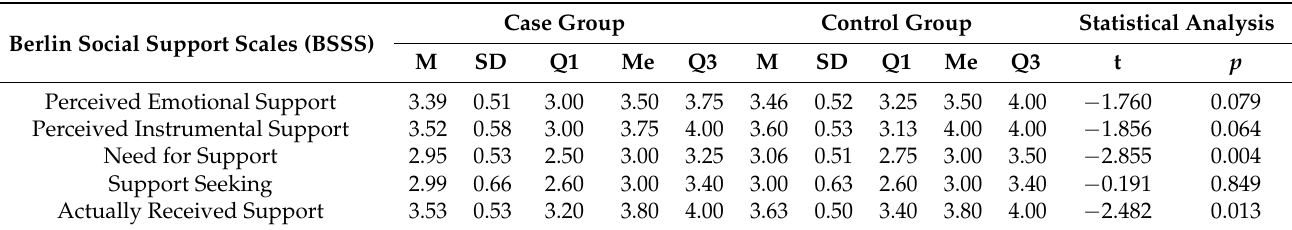
Table 2. The comparative analysis of social support in the study and control